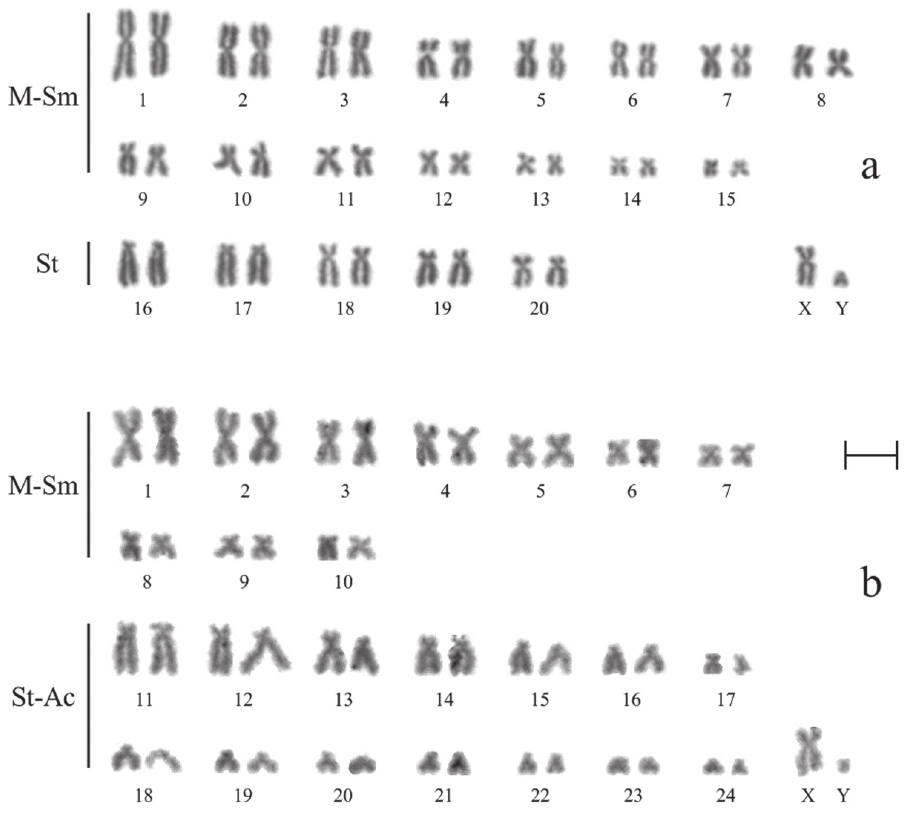
Figure 2. Routine stained karyotypes of Ochotona huangensis ( a ) and O. dauurica ( b ): M-Sm meta-sub- metacentric chromosomes, St subtelocentric chromosomes, St-Ac subtelo- and acrocentric chromosomes. Bar = 5